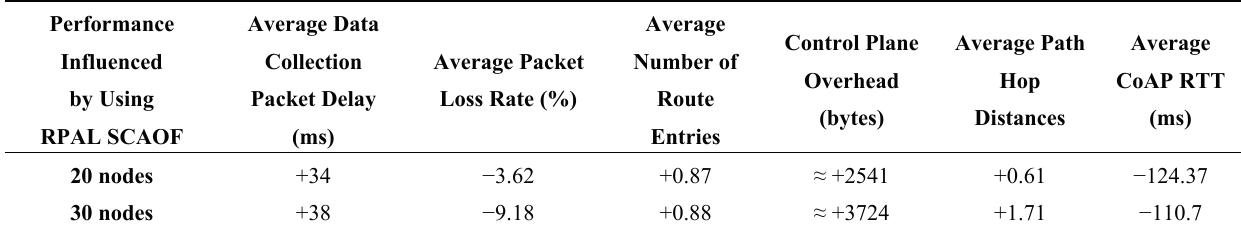
Table 8. General performance metrics of 20 and 30 LLN nodes